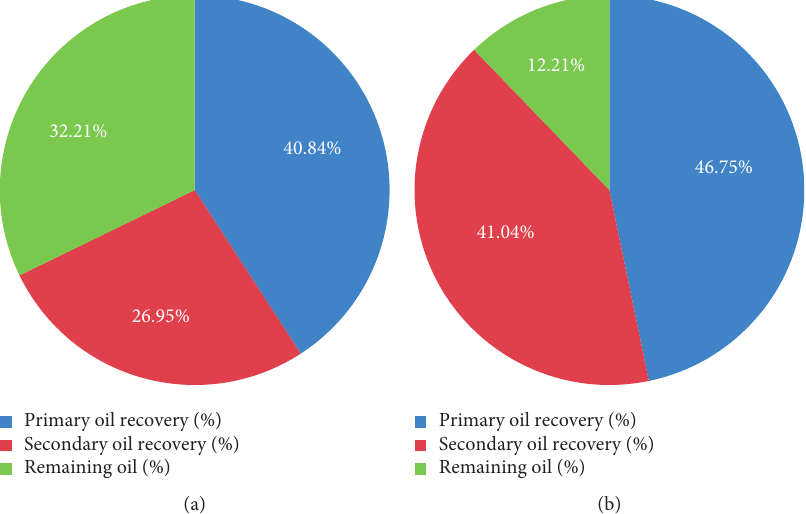
Figure 7: Cumulative performance of polymer gel and nanosuspensions flooding, (a) polymer gel injection, and (b) nanosuspensions injection.